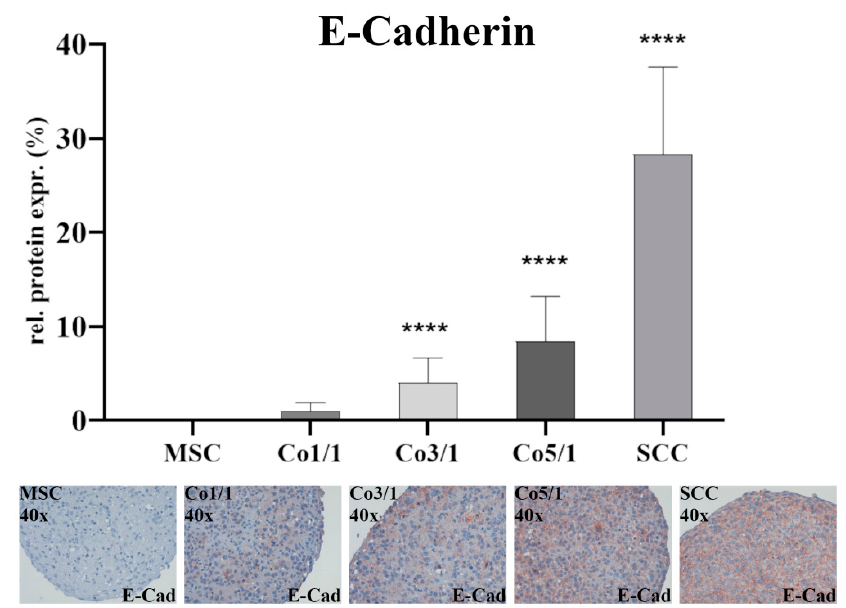
Figure 3. Immunohistochemical staining of E-cadherin in MSCs, Co 1/1, Co3/1, Co5/1, and SCCs; magnification 40×. **** = p ≤ 0.0001.